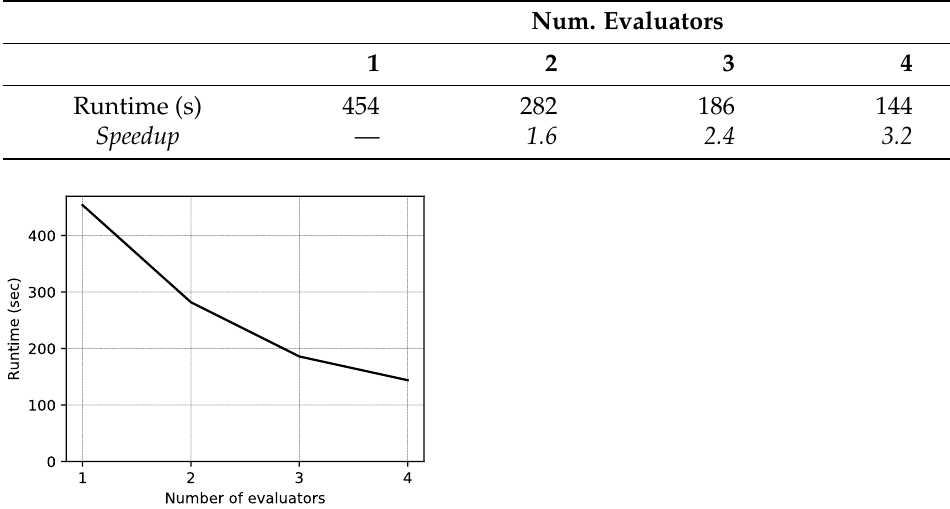
Figure 14. Efficiency of the upper layer of parallelization, where the runtime reduced when the number of evaluators